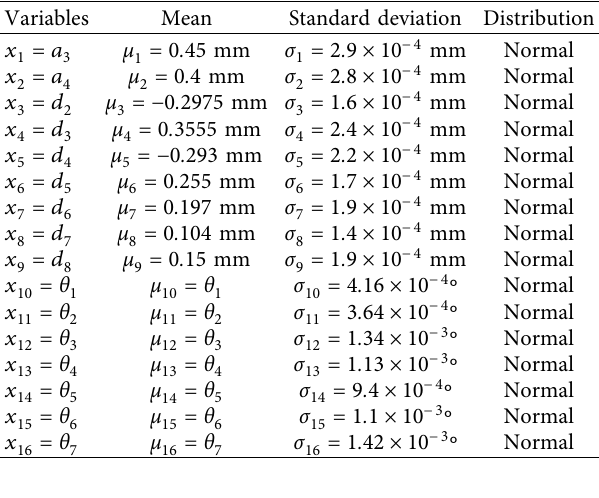
Table 2: Mean and standard deviation of variables.